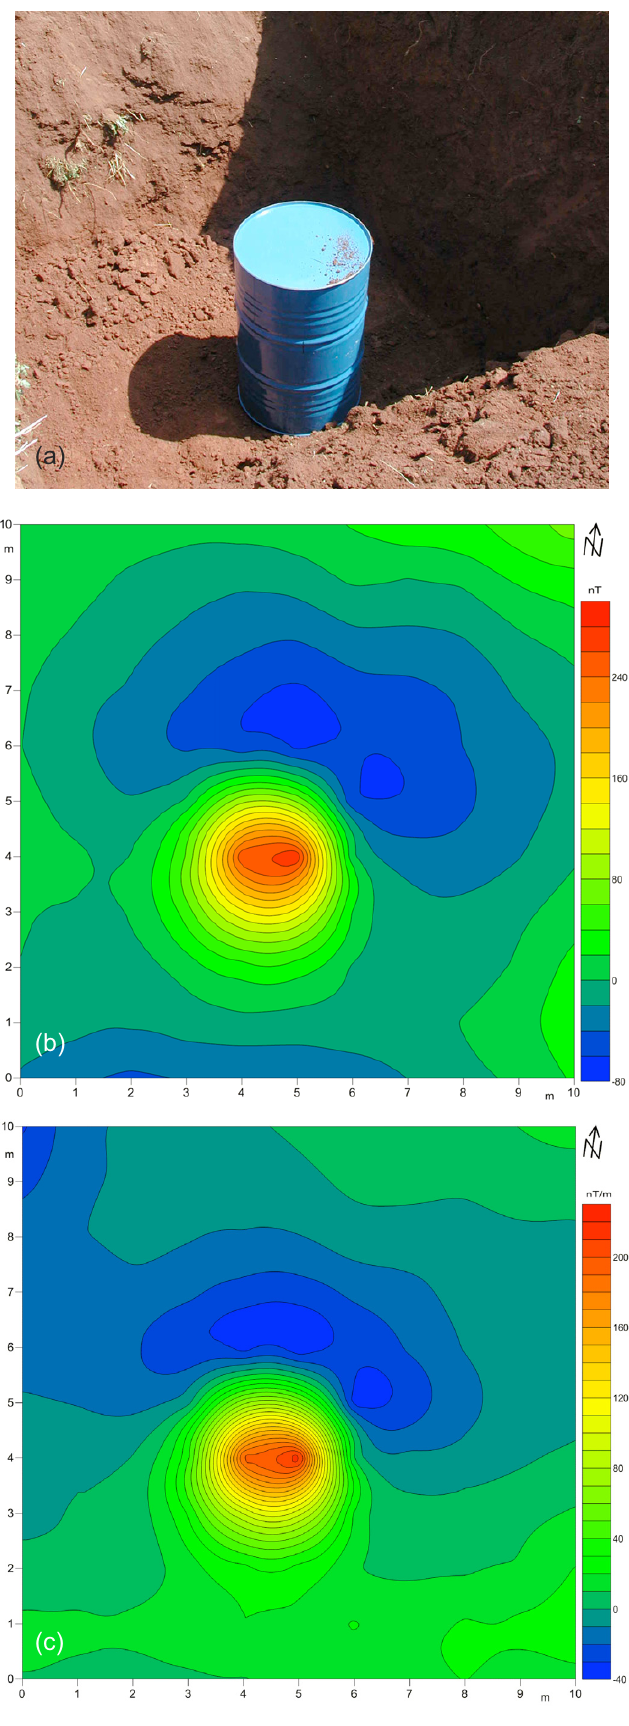
Figure 4. A single drum buried vertically. The magnetic inclination was around 58º. (a) Photograph of the preparation of the underground target. (b) Anomaly map of the total intensity field. (c) Map of vertical